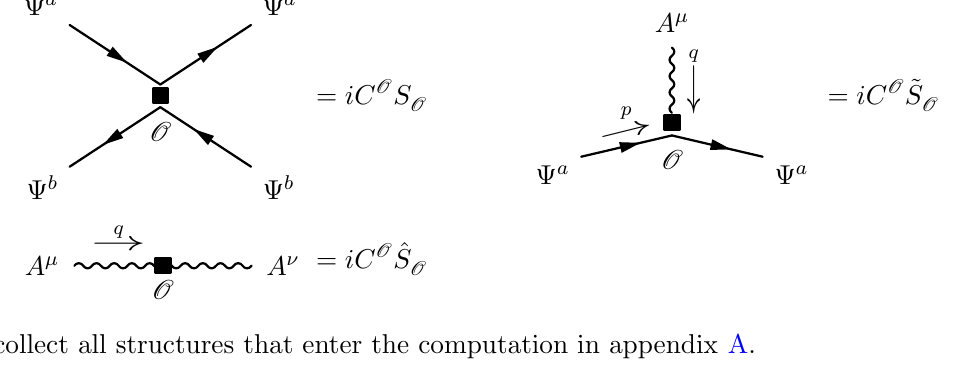
Figure 1 . An illustration of the non-trivial case of h N 1 i (2) eq. (A.10) . The squares denote operator insertions and the crosses counterterms. The (cid:12)rst paren- thesis collects two-loop insertions of the operator N 1 , which is a linear combination of N (cid:13) The second collects the one-loop insertions with counterterms on the propagators and the QED vertices. The third and fourth are one-loop insertions multiplied with the (cid:12)eld and charge renor- malization of the (cid:12)elds and charges composing the N 1 , see eq. (3.15) . The (cid:12)fth are the tree-level insertions multiplied with the two-loop (cid:12)eld and charge renormalization constant from the N (cid:13) denote the (cid:9)(cid:9)(cid:9)(cid:9) structures with S , the (cid:9)(cid:9) A (cid:22) ones with ~ S , and the A (cid:22) A (cid:23) one